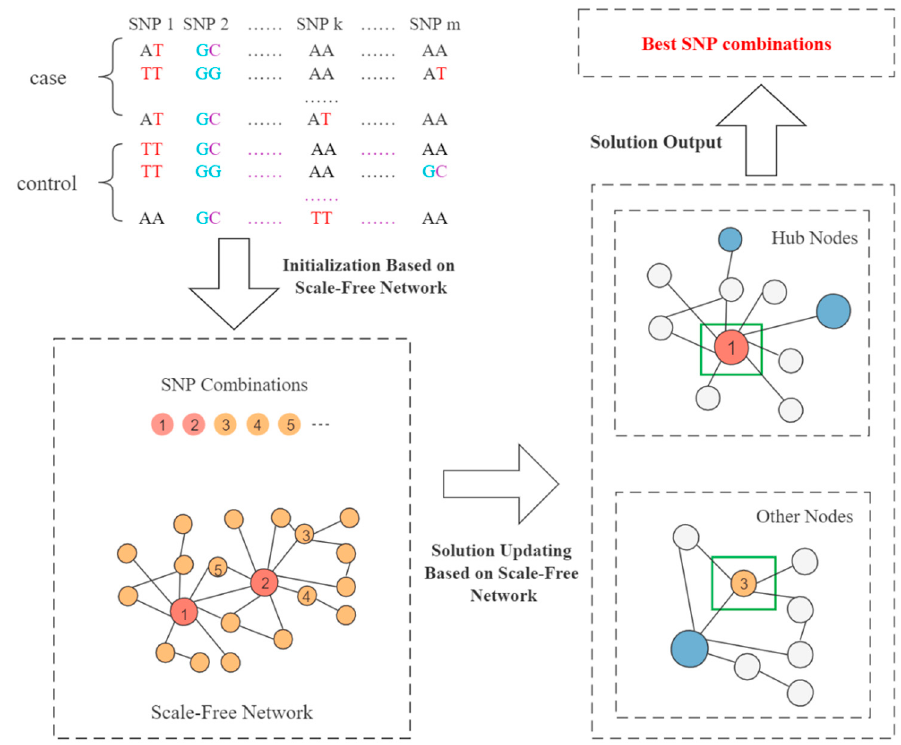
Figure 2. Framework of SFMOABC. The numbers in the figure represent the sequence numbers corresponding to the SNP combinations sorted in descending order according to the fitness value.